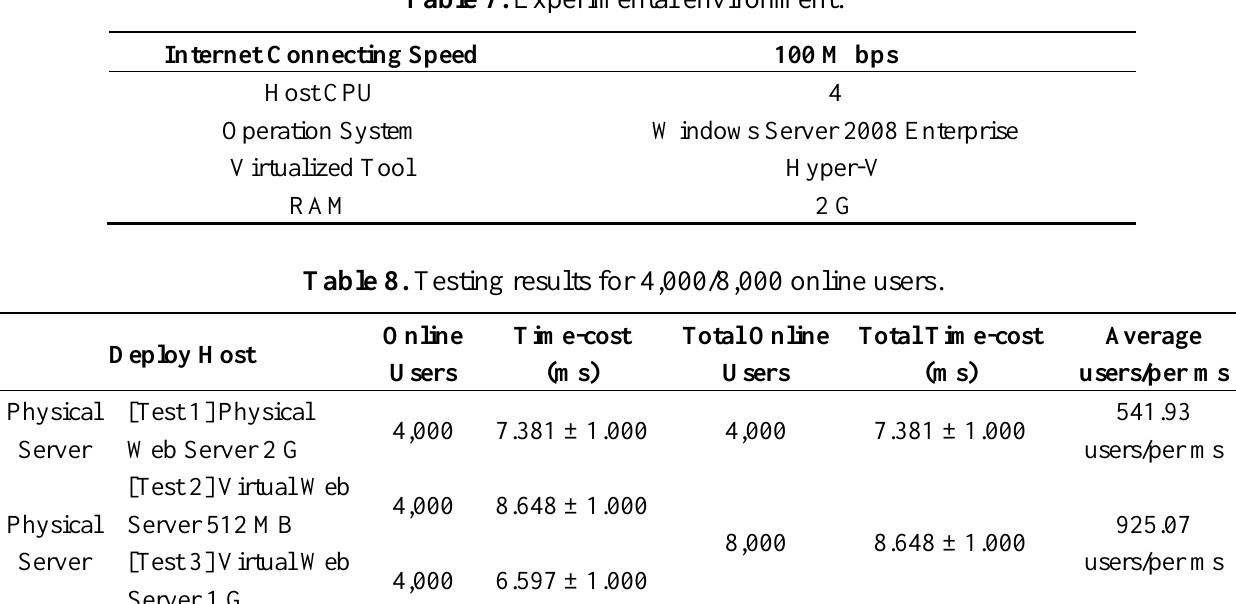
Table 7. Experimental environment.